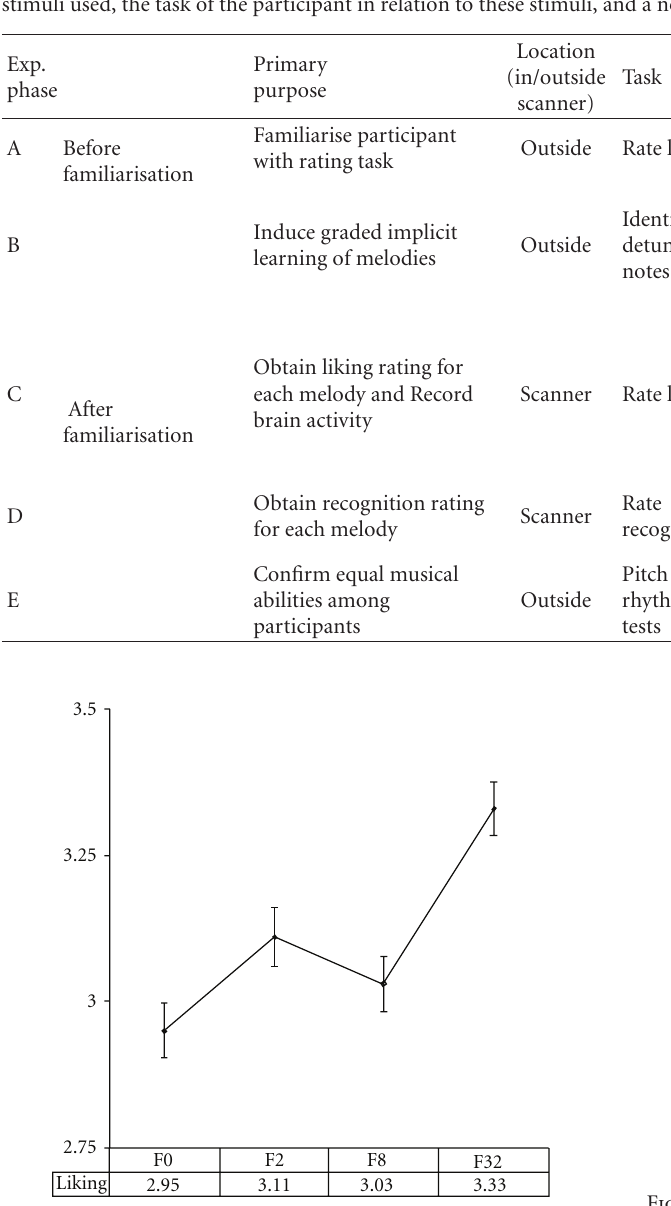
Figure 2: Liking and previous exposure. Mean liking rating as a function of previous exposure (melodies heard 0, 2, 8, or 32 times previously). Error bars represent standard error.